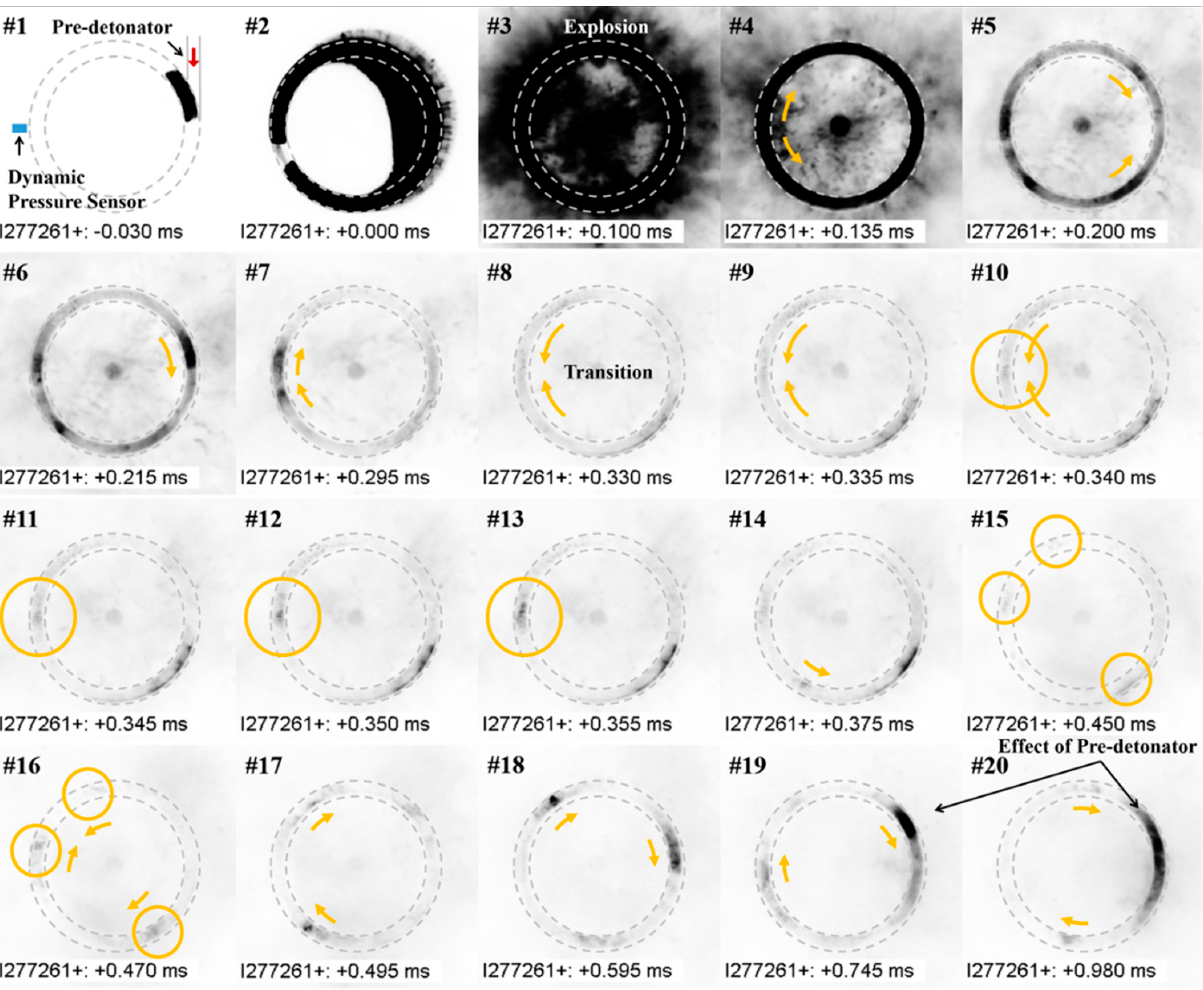
Figure 7. Snapshots of the detonation initiation and transition process captured at 256 × 256 resolution and 200 kilo-frames per second (kfps). The event times and experimental conditions correspond to Figure 6a.